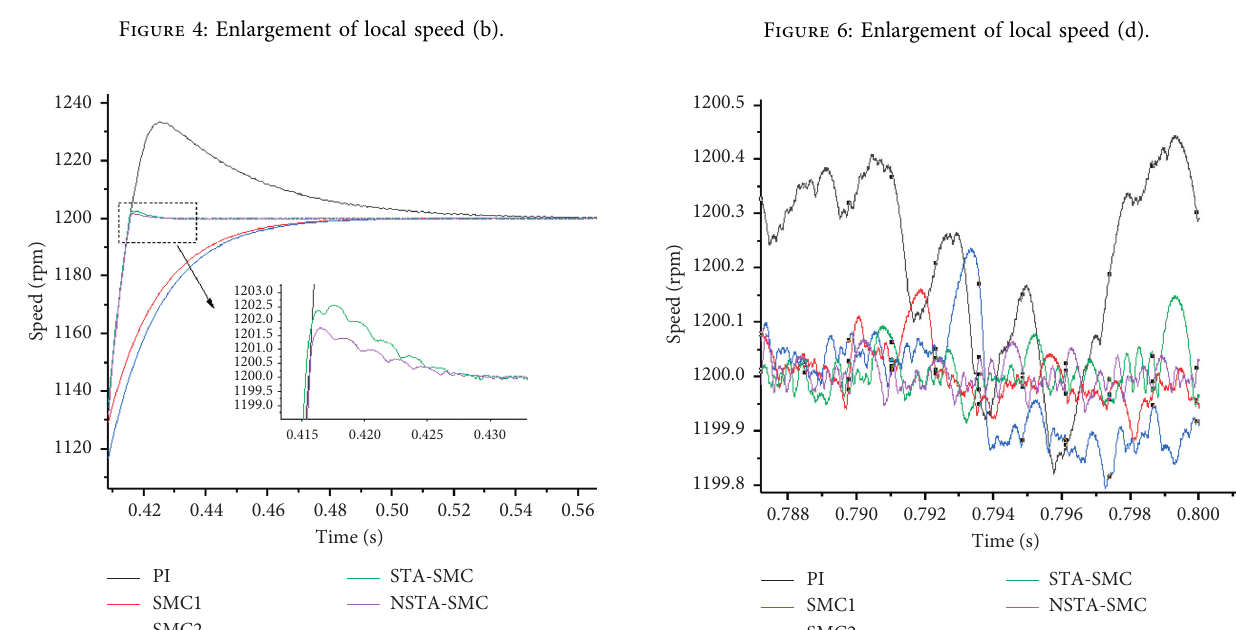
Figure 7: Enlargement of local speed